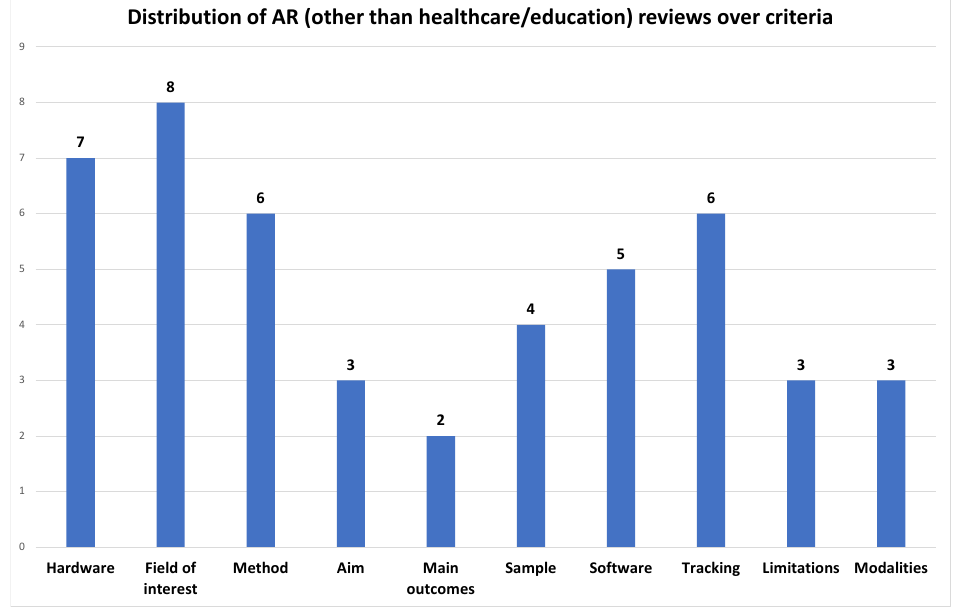
Figure 7. Distribution of AR education reviews over criteria (min: 2–max: